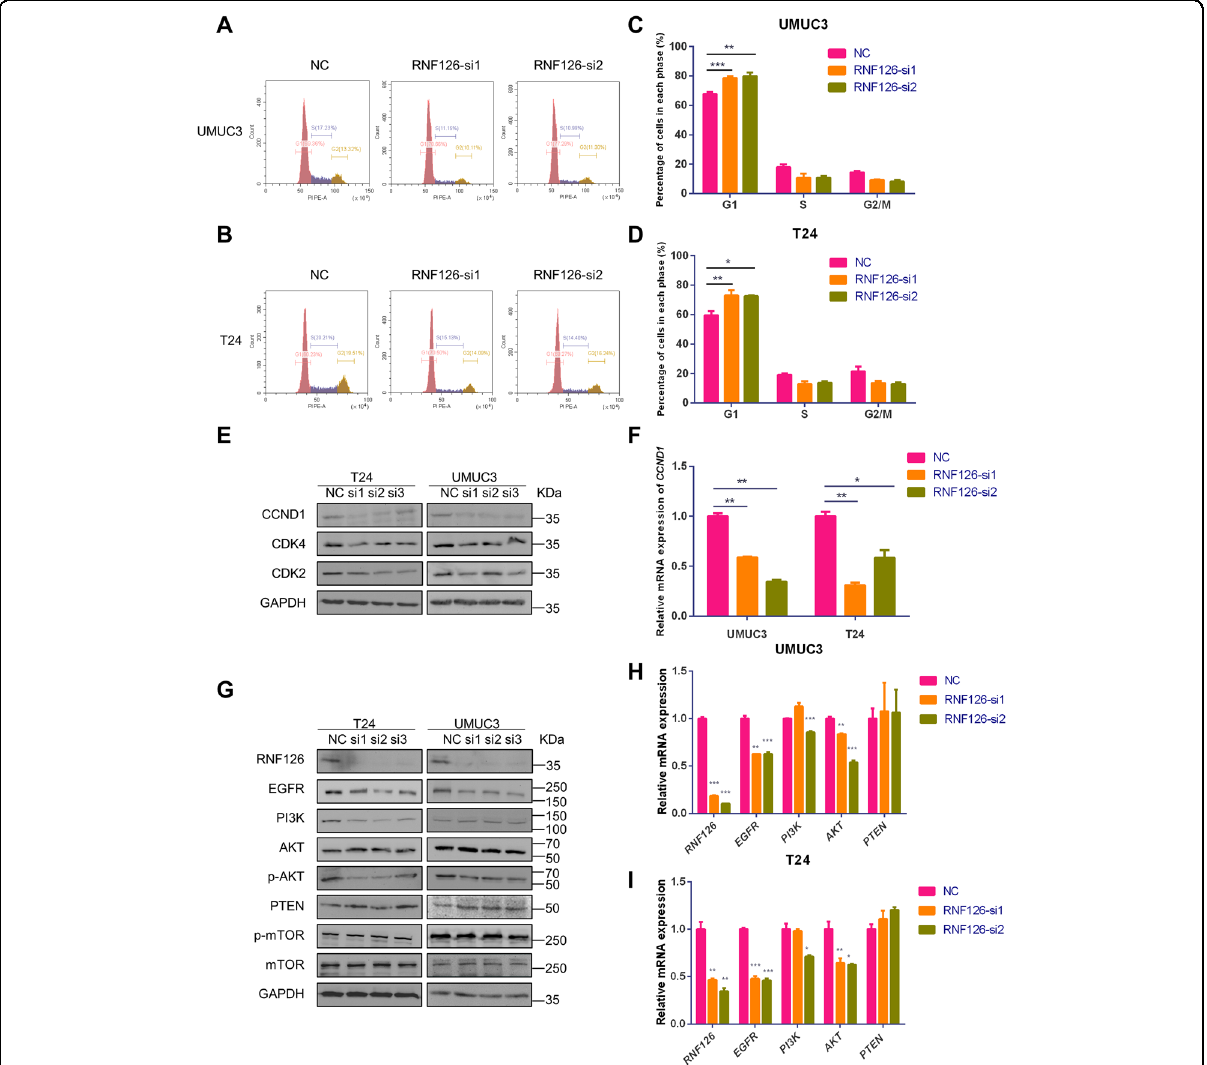
Fig. 3 RNF126 de fi ciency affects the cell cycle and EGFR/PI3K/AKT signaling pathway in BCa cells. A , B The fl ow cytometry analysis demonstrated the percentage (%) of cells in different phases of cell cycle. The T24 and UMUC3 cells were treated with RNF126 -si1 and si2 for two days. C , D The percentage (%) of cells in each phase was statistically analyzed from three independent experiments. E The western blotting revealed downregulation of protein associated with the cell cycle (CCND1, CDK2 and CDK4) in the BCa cells after silencing RNF126 . The internal control was GAPDH. F The relative mRNA level of CCND1 in different cell types, treatment of siRNA. H The western blotting showed the protein level of EGFR, PI3K, total and phosphorylated AKT, mTOR, and PTEN in BCa cells treated with RNF126 -si1and si2. The internal control was GAPDH. I The relative mRNA level of EGFR , PI3K , AKT , PTEN in different cell types, and siRNA treatment. *** p < 0.001, ** p < 0.01, * p <